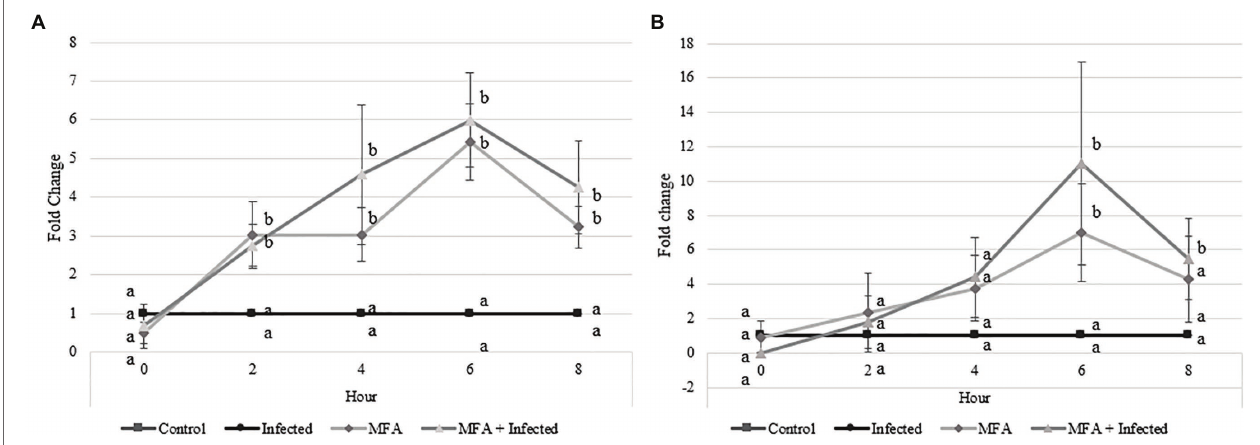
FIGURE 2 | Impact of microbial fermentation application (MFA) on gene expression levels of defense genes in healthy and infected Citrus sinensis trees. Data represent gene expression of (A) beta-1,3-endoglucanase (PR2) and (B) phenylalanine ammonia lyase (PAL) over 5 time points 0, 2, 4, 6, and 8 h after MFA treatment ( n = 7). Both treatments were normalized to their respective controls. MFA trees were normalized to control trees, and MFA + infected trees were normalized to the infected group. Letters that are the same within each time point indicate no differences between groups ( p > 0.05). Error bars indicate ±